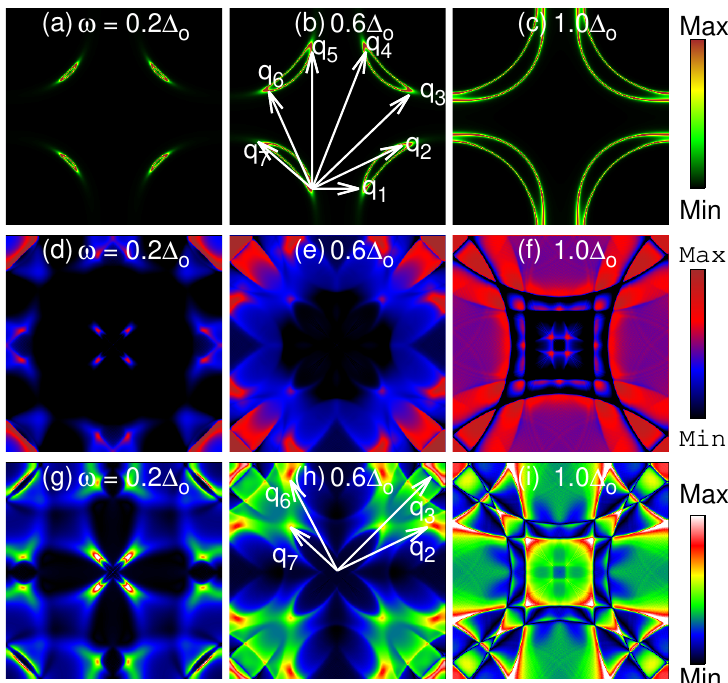
within the o . (d-f) o